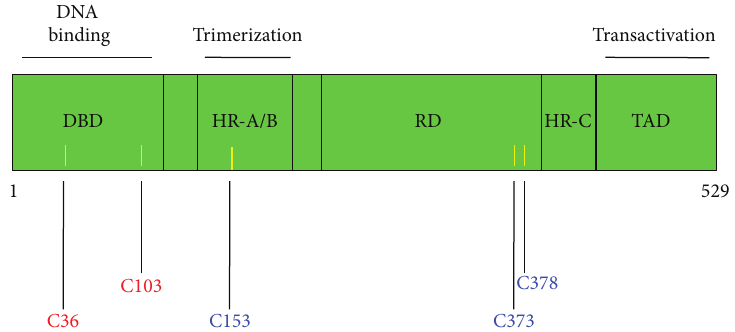
F 3: Domain structure of human HSF1. DBD: DNA-binding domain (amino acids 1–110); HR-A/B: heptad repeat regions A and B (amino acids 130–203); RD: regulatory domain (amino acids 221–383). is domain negatively regulates the transactivating activity of HSF1; HR-C: heptad repeat region C (amino acids 384–409); TAD: transactivation domain (amino acids 410–529). HSF1 trimerizes through intermolecular interactions between the HR-A/B regions. Trimerization is negatively regulated by intramolecular interactions between the HR-A/B heptad repeat region and the HR-C domains within the monomer. e positions of the cysteine residues are indicated with yellow bars. e cysteine residues which participate in activating intermolecular disul�de bonds are shown in red, and those which participate in inactivating intramolecular disul�de bonds are shown in blue. Dimerization and co chaperone bindingCo chaperone chaperone and client and ATP binding protein binding